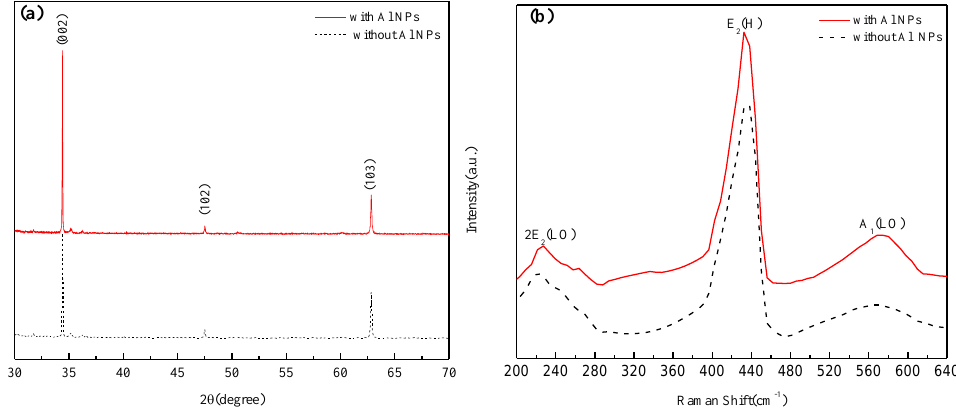
Figure 2. XRD spectra ( a ) and Raman spectra ( b ) of ZnO NRs decorated with and without Al NPs.